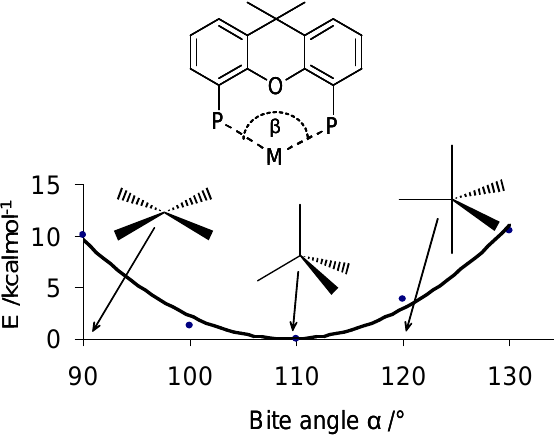
Figure 3 . (top) The bite angle ( α ) is the angle formed when a bidentate ligand coordinates to a metal centre; (bottom) A flexibility profile showing the energy change vs. the bite angle. In this example, square planar co-ordination structures ( α = 90º) are disfavored (10 kcal above the